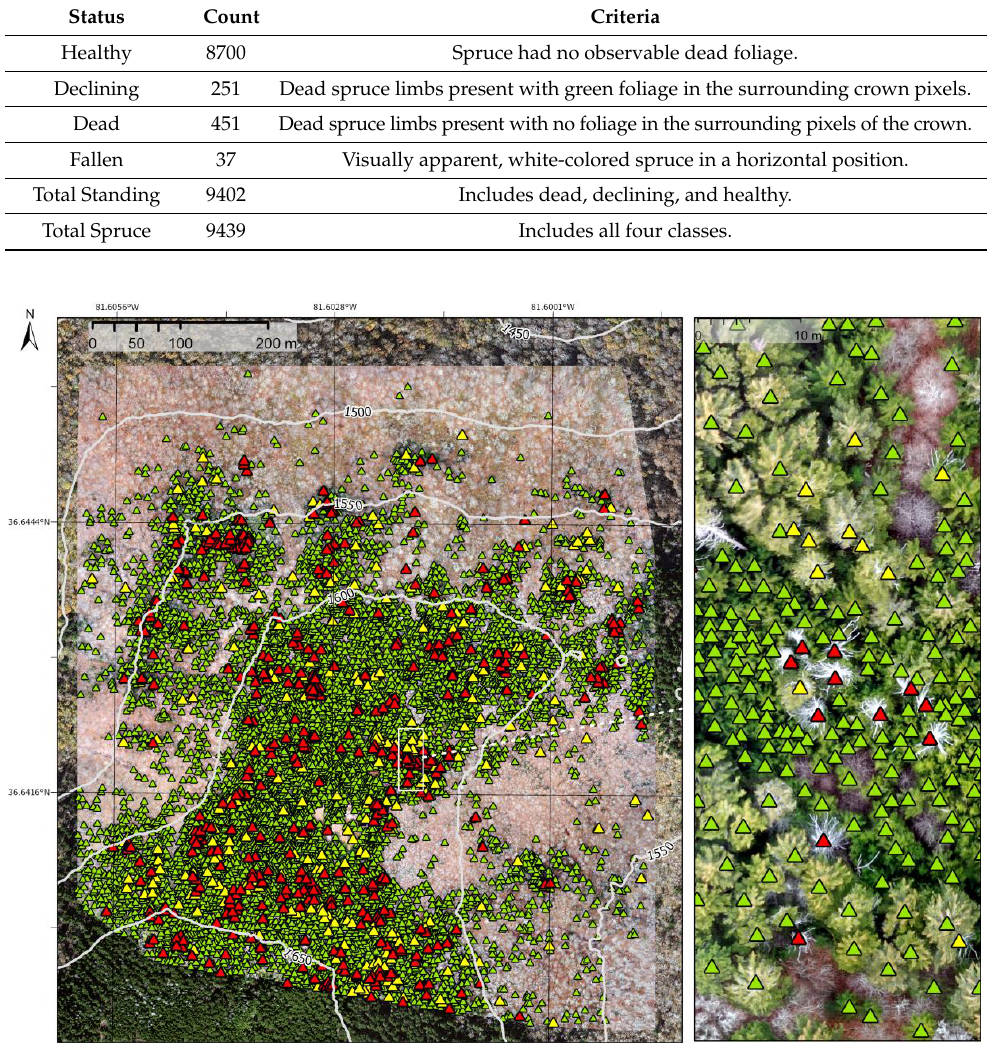
Figure 3. Left : Individual spruce within the sample plot categorized visually based on their ap- parent health. Bottom right : triangles represent classified spruce (red = dead, yellow = declining, green = live). Contour lines in meters above sea level, background image courtesy of NAIP